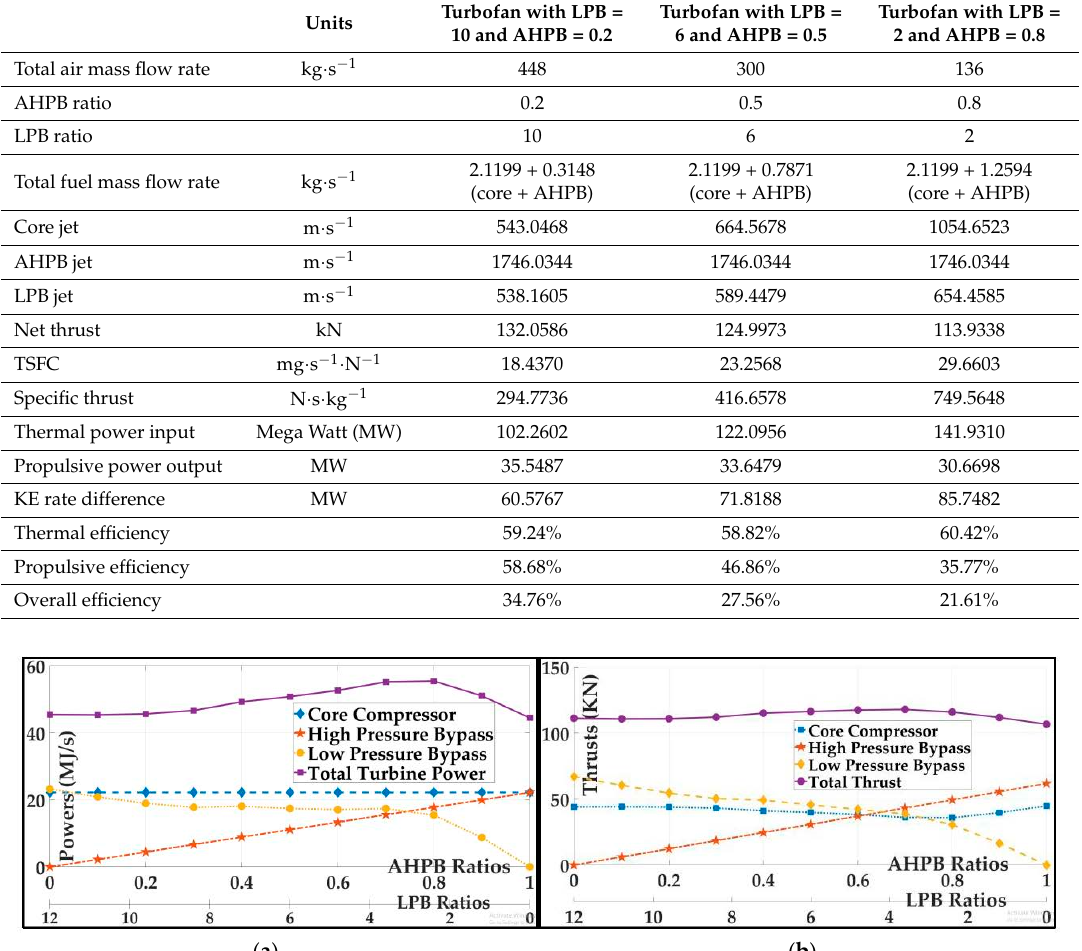
Figure 3. Plots of ( a ) thrust-specific fuel consumption (TSFC) vs. specific thrust and ( b ) efficiencies as a function of bypass ratios. 4.2. Constant Low-Pressure Bypass Ratio with Varying Auxiliary High-Pressure Bypass Ratios Here, the LPB ratios were maintained constant while the AHPB ratios were varied between α AHPB = 0 and α AHPB = 1 in increments of 0.1. It is to be noted here, again, that the fan pressure ratio for each LPB ratio simulation was chosen so as to maximize the engine thrust and, potentially, the overall efficiency [1]. 4.2.1. Thrust-Specific Fuel Consumption vs. Specific Thrust To provide an insight into the utility of AHPB provision, the results of simulating these parameters as a function of varying AHPB ratios for various fixed LPB ratios are shown in Figure 4. The LPB ratios for the results shown in Figure 4 were chosen to be LPB = 2 (Figure 4a), LPB = 6 (Figure 4b), LPB = 10 (Figure 4c), and LPB = 12 (Figure 4d). As is evident from these results, the AHPB provision has a significant impact for aircrafts with relatively small LPB ratios. For an aircraft with an LPB ratio of 2, the specific thrust increases by ~20% for a ~40% increase in TSFC as the AHPB ratio goes from 0.1 to 1. Similarly, for an aircraft with an LPB ratio of 6, the specific thrust increases by ~20% for a ~70% increase in TSFC. Although the increase in specific thrust does not translate to a proportional increase in TSFC, it should be observed that a net increase in the specific thrust of an engine due to the introduction of an AHPB stream in a turbofan engine with a set LPB ratio is significant. The most critical inference of the simulation results presented in Figure 4 is that an AHPB provision may be more suited for turbofan engines with low LPB ratios. 4.2.2. Efficiencies vs. Net Thrust The plots of efficiencies vs. net trust as a function of varying AHPB ratios for various fixed LPB ratios is shown in Figure 5. For an aircraft with an LPB ratio of 2, the net thrust increases by ~60% as the AHPB ratio goes from 0.1 to 1. The propulsive efficiency of the aircraft with this configuration (LPB ratio = 2) decreases by ~30%, almost entirely contributing to the decrease in the overall efficiency by a similar amount. The impact on thermal efficiency is almost negligible. Similarly, for an aircraft with